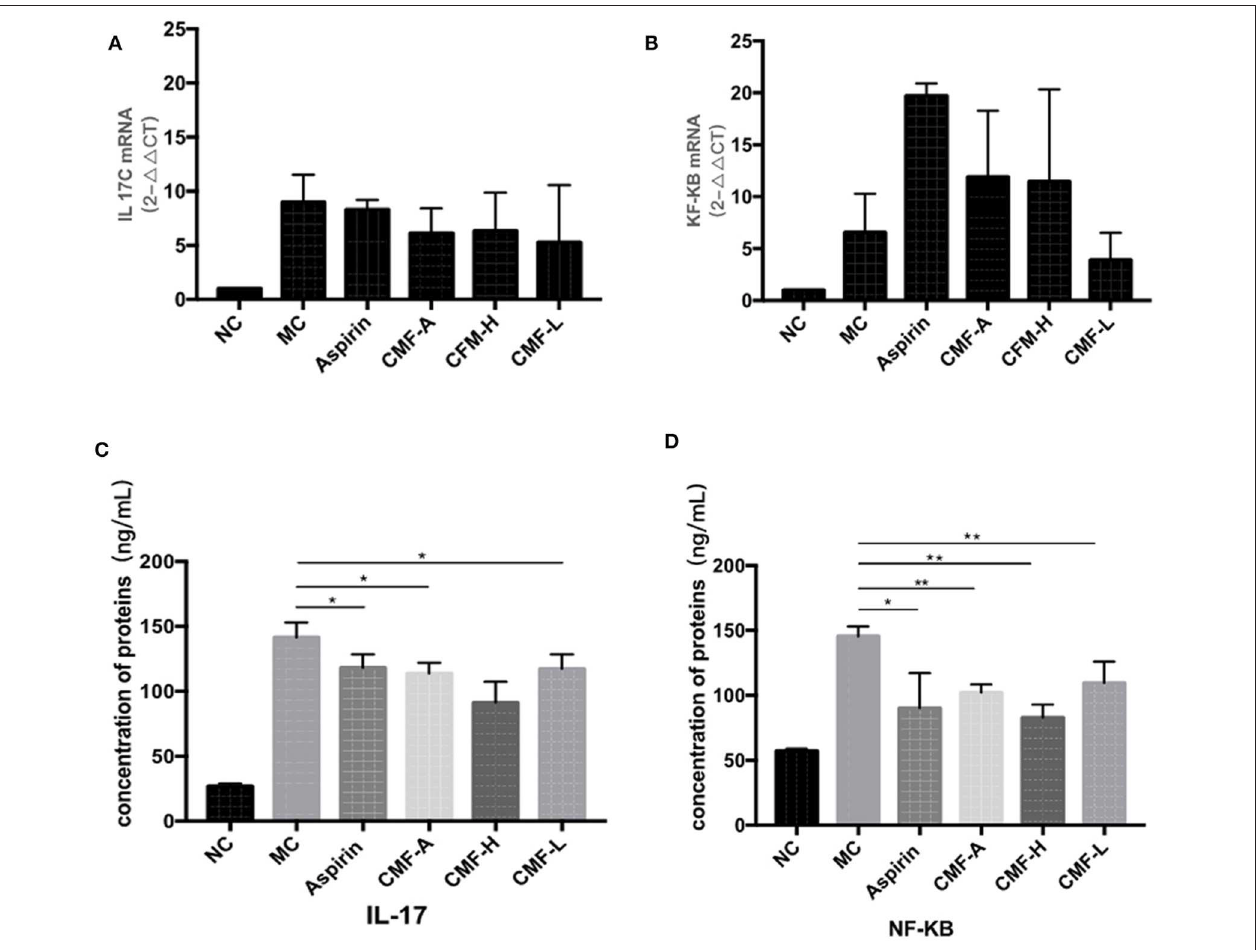
FIGURE 3 | CMF changed the inflammatory microenvironment and regulated the expression of IL-17C and NF- κ B in vivo . mRNA level of IL-17C (A) and NF- κ B (B) in the colonic tissues were measured by real-time RT-PCR. All data are expressed as the mean ± S.D, * P < 0.05, ** P < 0.01 compared with AOM/DSS group. The level of IL-17C in serum (C) and the level of NF- κ B in tumor tissue homogenate (D) were measured using ELISA kits. All data are expression as the mean ± S.D, * P < 0.05, ** P < 0.01 compared with AOM/DSS